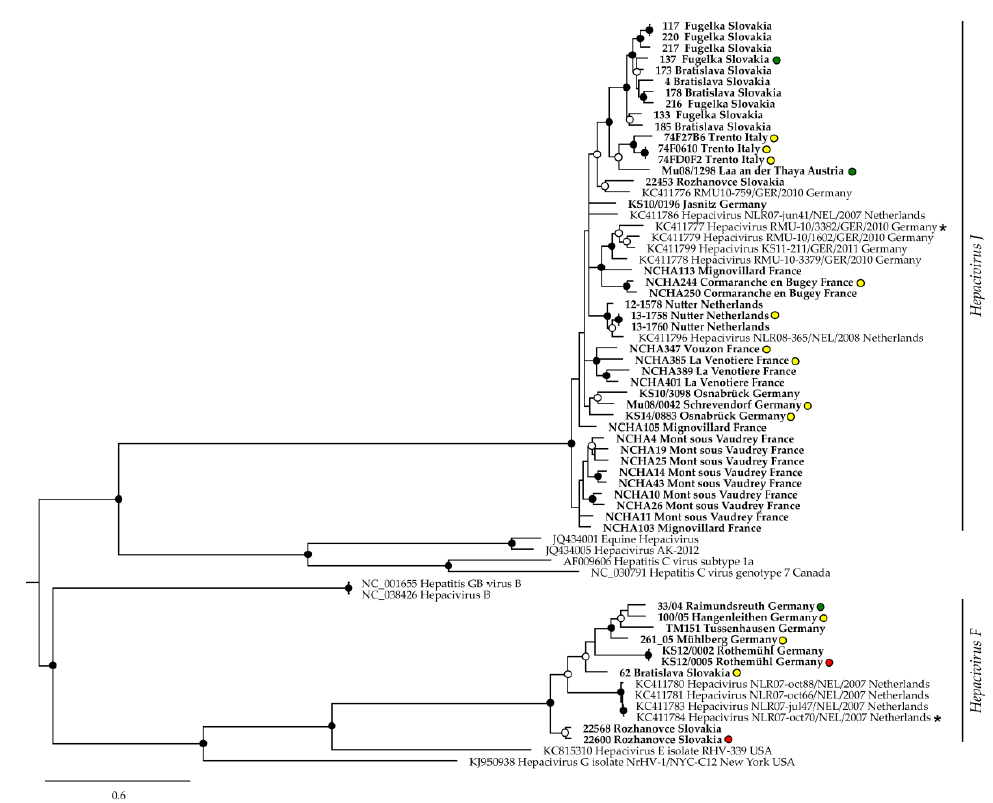
Figure 2. Phylogenetic relationships of partial BvHV NS3 sequences (472 nt). Sequences generated during this study are highlighted in bold. Circles at nodes indicate Bayesian posterior probabilities: black: probability exceeds 90%; white: probability exceeds 70%. The names of sequences obtained from GenBank include their accession numbers. Colored circles to the right of sequence names indicate the evolutionary lineage of the bank vole: yellow: Western lineage; red: Eastern lineage; green: Carpathian lineage. Asterisks mark type strains of both virus